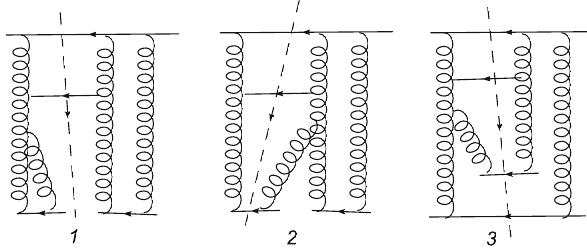
Fig. 9 Cut amplitudes with vertex (cid:2) R → RRG and rescattering after reduction in Fig. 2